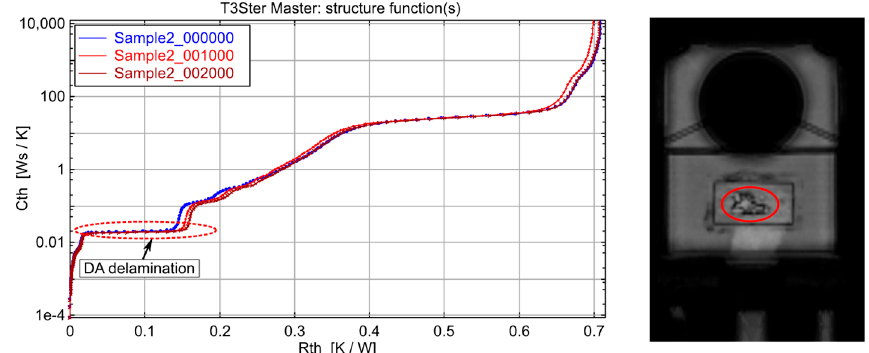
Figure 10. Structure function of Sample 2 in the initial state (blue) and after every one thousand cycles (red, brown.), in the original position (left) and the C-SAM image of the die-attach layer (right). Selecting an appropriate feature in the structure after the degraded layer and fitting the curves at the corresponding section could also help analyze also the further sections. On the right hand side diagram in Figure 11, the curves were shifted horizontally to overlap at the section that corresponded to the copper base-plate of the device. This was a well-defined capacitance step on the curves. This fitting revealed the same type of change in the section corresponding to the first TIM layer that we saw in the case of Sample 1 (Figure 9) as well. Using this method, the concurrently arising failure modes could be separated and analyzed individually. Figure 11. Structure function of Sample 2 in the initial state (blue) and after every one thousand cycles (red, brown) shifted right to fit at base-plate capacitance step. 3.2. Bond-Wire Degradation and Separation of the Effects As the bond-wire degradation did not contribute significantly to the cooling of the chip (it was not part of the heat-flow path), its integrity could not be investigated using the captured thermal transient curves. However, an accurate voltage measurement could detect the small changes in the device voltage caused by the increasing serial resistance, represented by the damaged bond wires. Some high-power modules contain dedicated bond wires for controlling the transistor (as can be seen in Figure 12), but in order to monitor the bond wires we need to make sure that the voltage measurement probes were connected to the high current inputs of the module. As the cumulative resistance of the bond wires was very low, the voltage drop needed to be measured when the heating current was applied on the device.